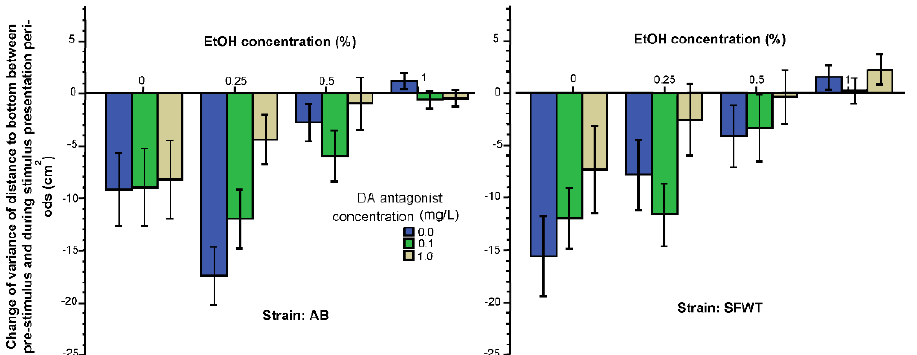
Figure 5. Change of intra-individual temporal variance of distance to bottom (vertical exploration) elicited by the presentation of animated conspecific images is influenced by the concentration of acute alcohol (X-axis) and by the concentration of acute D1-R antagonist (legend) in an additive manner. Mean ± S.E.M. are shown.